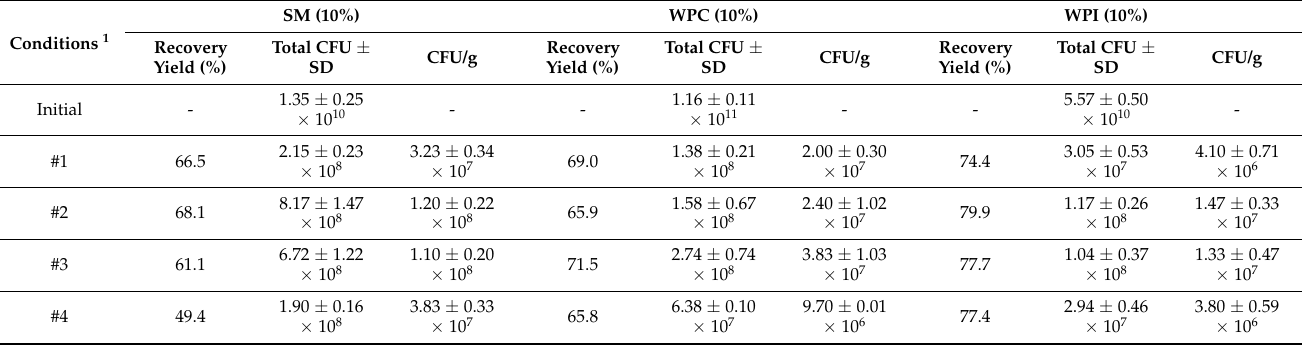
Table 1. Final masses, in grams, and A. muciniphila viable cells obtained for each protective matrix and condition tested. Total number of cells incorporated (“Initial”) into each matrix and recovered in each condition. CFU = colony-forming units; SD = standard deviation. For further information regarding the settings of conditions #1 to #4, check Table 3 in Section 3.2 of Material and